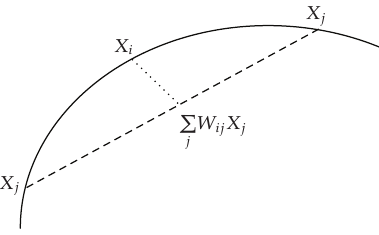
Figure 2: Reconstruction weights of face data and its